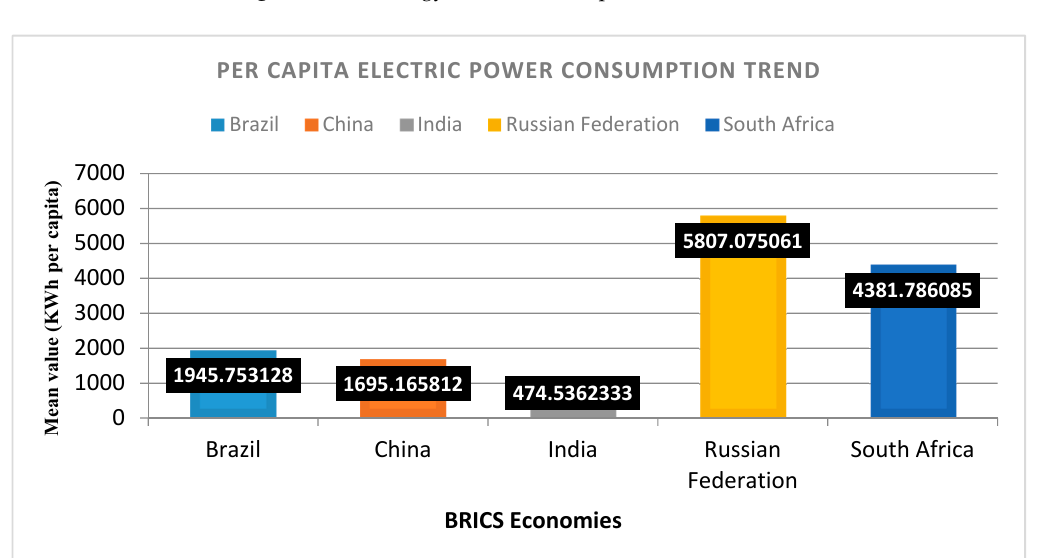
Figure 2. Technology innovation snapshot of BRICS [27].